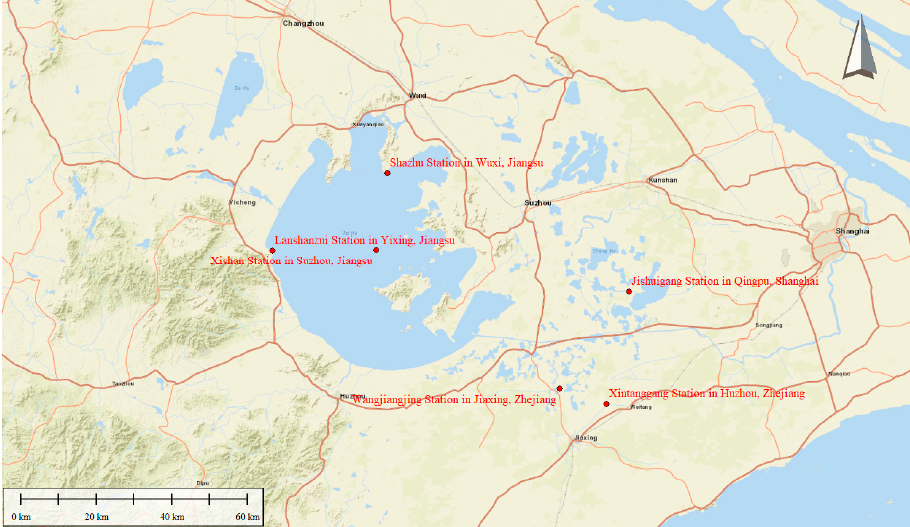
Figure 2. Geographical location map of monitoring stations.